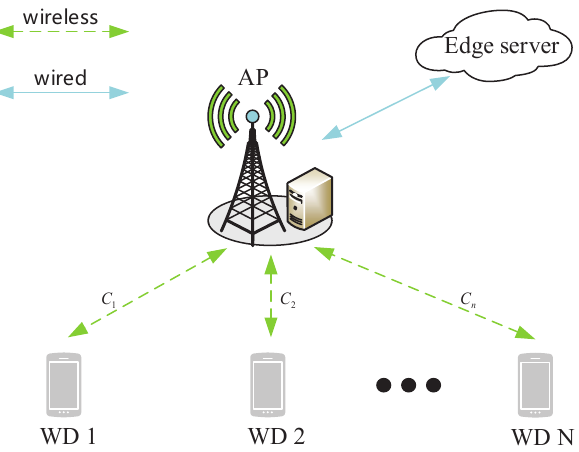
Figure 1. System model of an MEC network with multiple